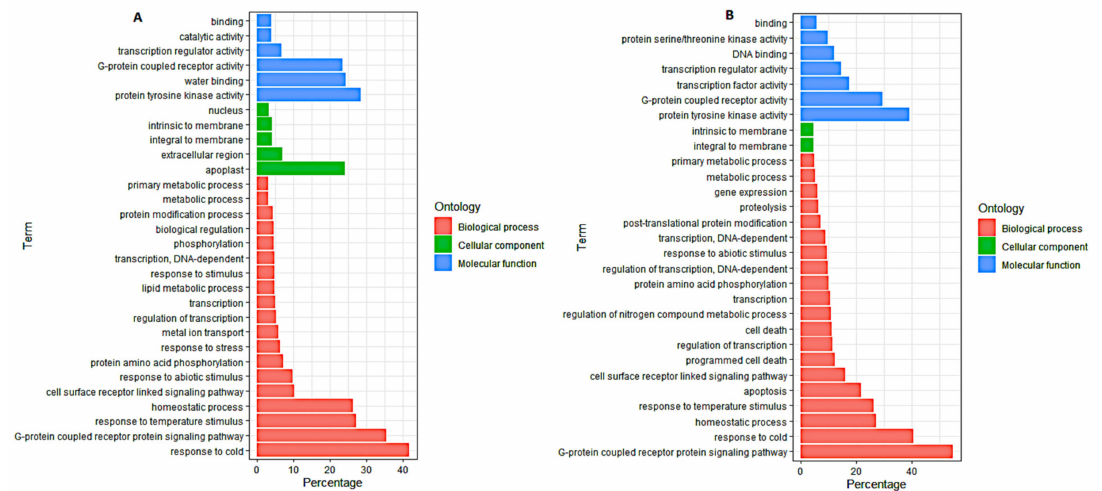
Figure 6. Gene Ontology (GO) enrichment analysis. ( A ) The 779 DEGs highly enriched in the tolerant lines. ( B ) The 877 DEGs highly enriched in the sensitive lines. The GO terms shown here are the top-most biological process (BP), molecular function (MF), and cellular component (CC)